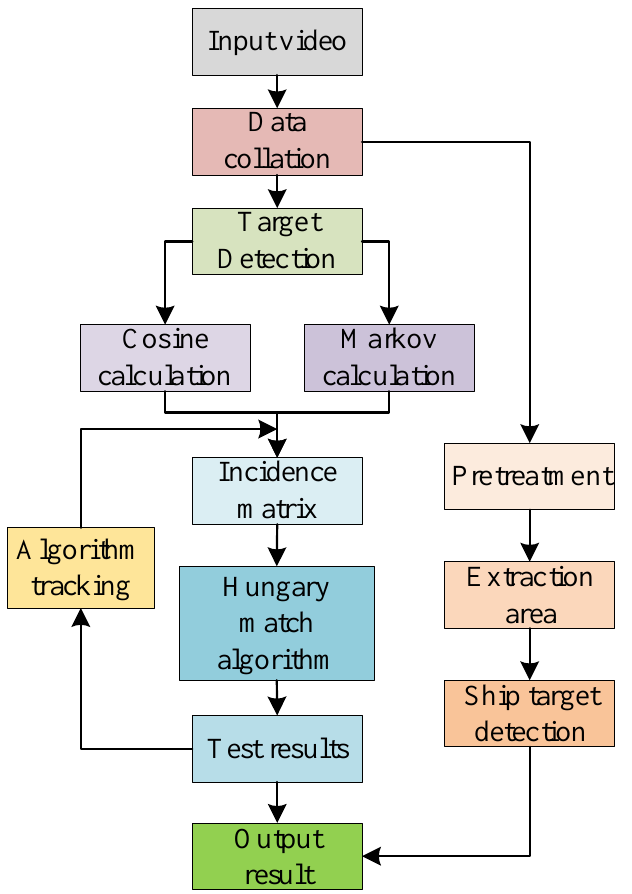
Figure 5. The fusion detection process of the improved YOLOv4 and UKF algorithm.